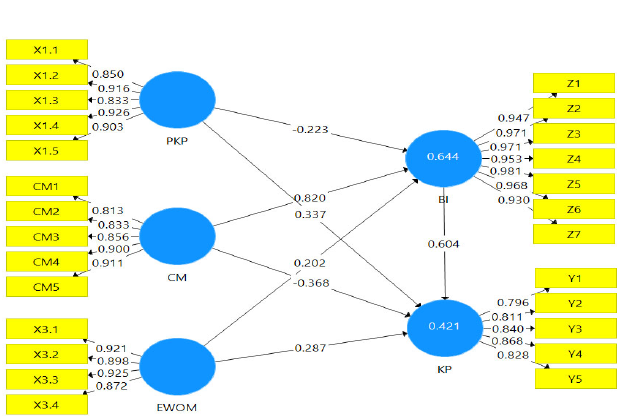
Fig. 1. The results of outer